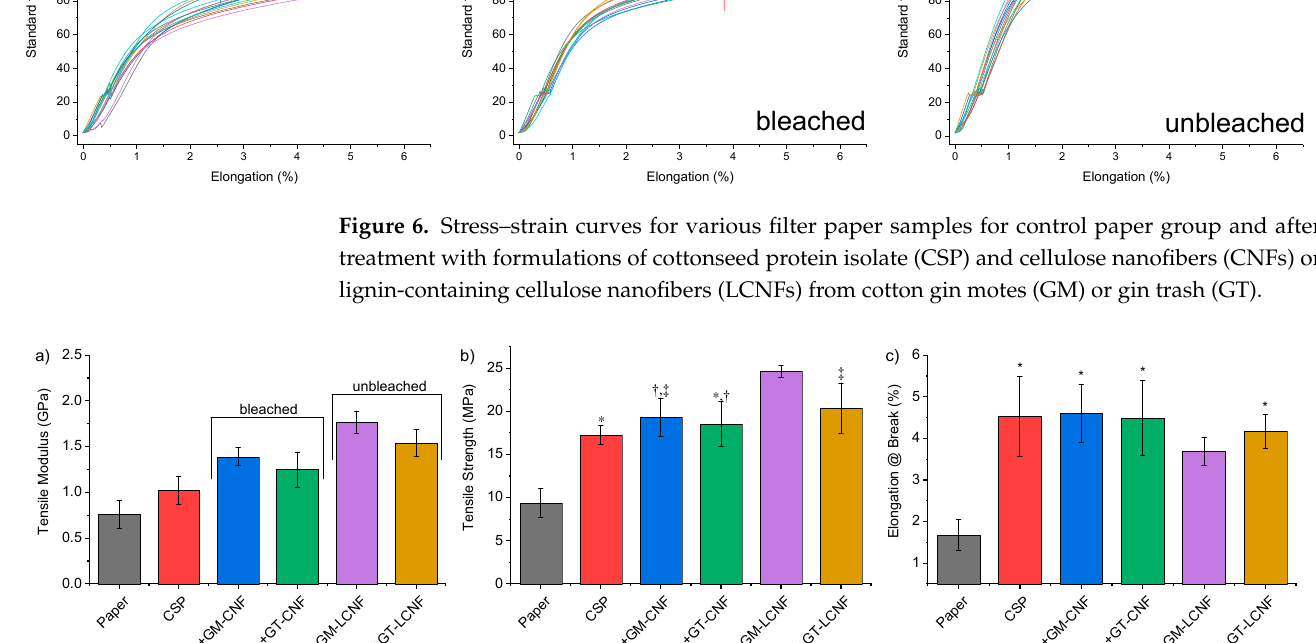
Figure 7. Results of mechanical testing of paper treated with cottonseed protein and cellulose nanofiber dispersions: ( a ) tensile modulus; ( b ) tensile strength; ( c ) elongation at break. * Note: Each data point represents seven strips tested in triplicate (21 total tests per entry). Data bars with the same symbol (*, †, or ‡) indicate the treatments are not signi fi cantly di ff erent at p < 0.05.